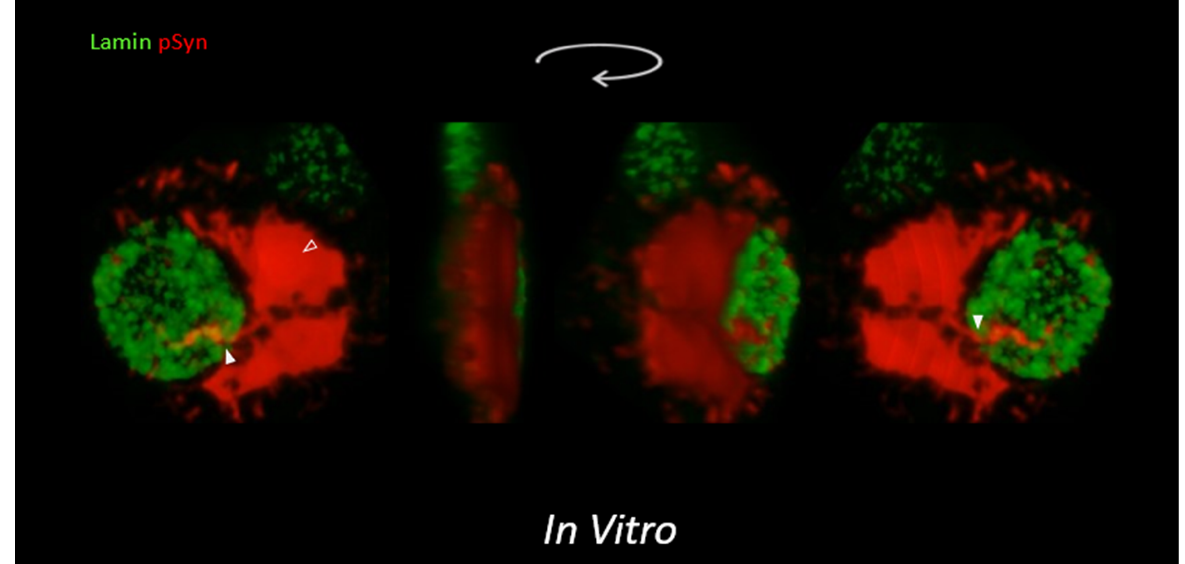
Figure 9. A 3D reconstruction and rotation of a Z-stack of LSCM optical sections of a single 30 DIV mouse primary cortical neuron treated at DIV7 with 1B fibrils. Nuclear Lamin coded in green; phospho-S129 α -Syn (pSyn) coded in red showing a bifid NCI (empty arrow) plus NII (plain arrow). Scale bar: 10 μ m.